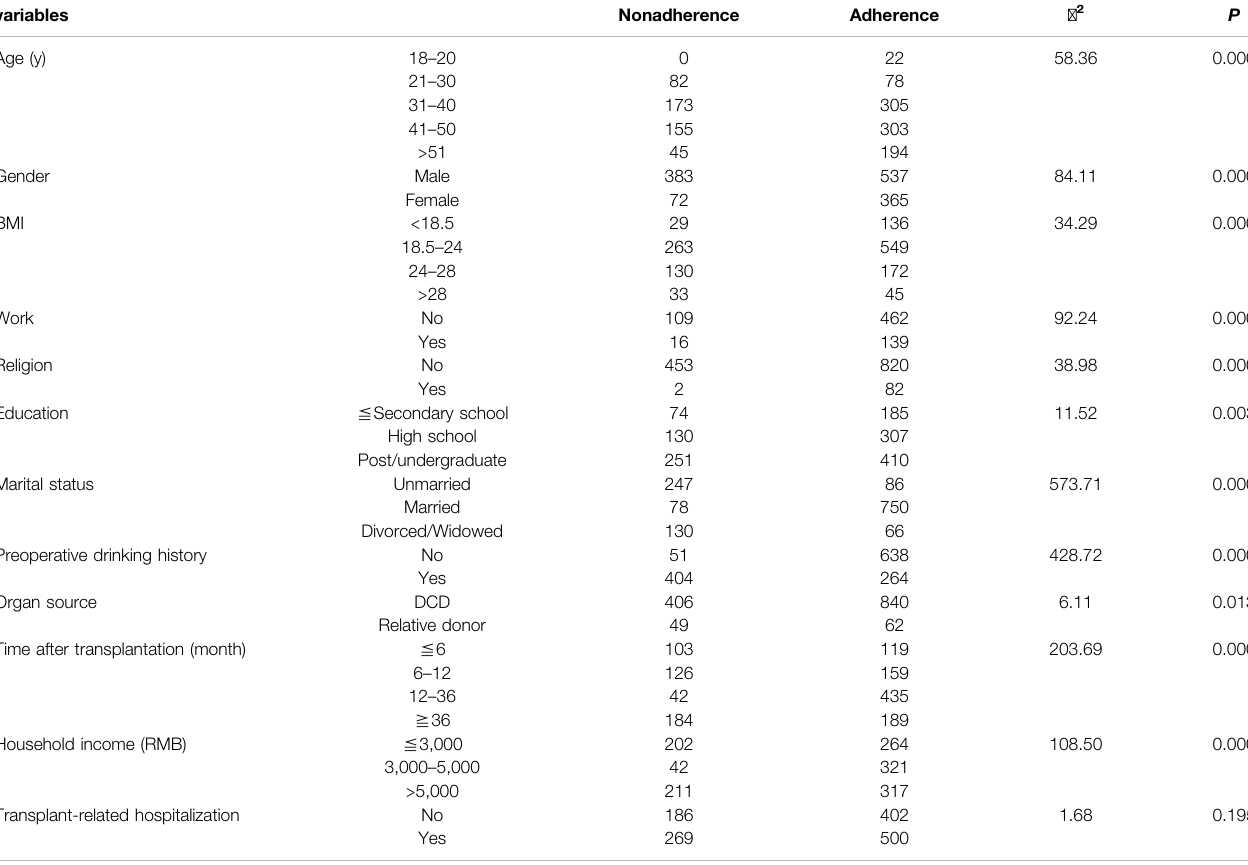
TABLE 3 | Univariate analysis of the association between sociodemographic characteristics and IM adherence among RTPs. variables Age (y)